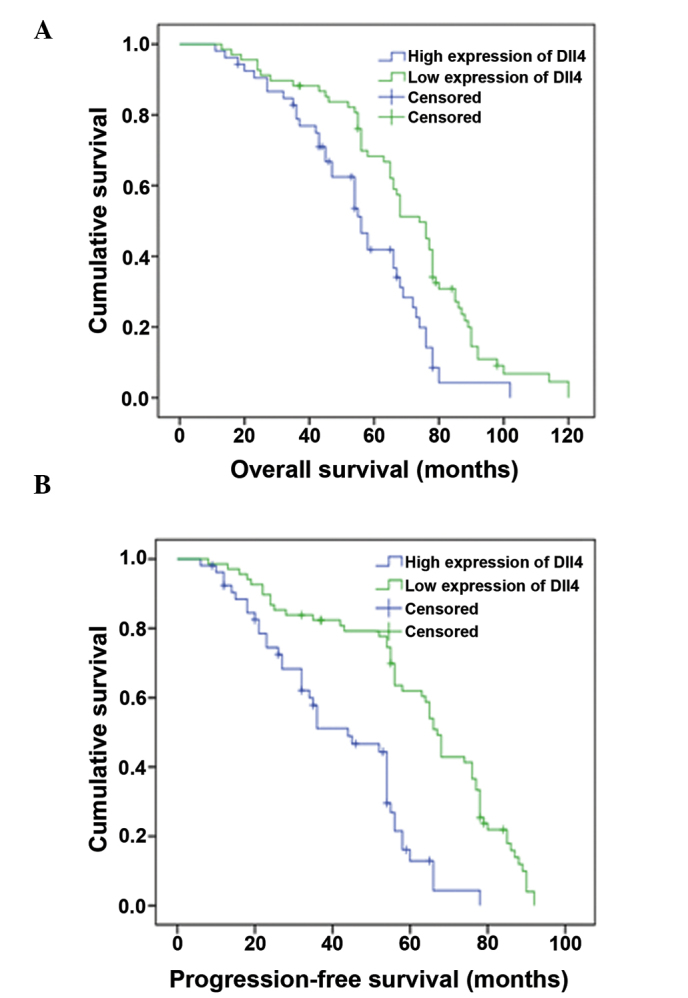
Kaplan-Meier estimates of cumulative overall survival and progression-free survival times, according to delta-like ligand 4 (Dll4) expression levels in clear cell renal cell carcinoma groups. (A) Significant differences in overall survival times were observed between the high and low Dll4 expression subgroups (P<0.001). (B) Significant differences in progression-free survival were observed between the high and low Dll4 expression subgroups (P<0.001).